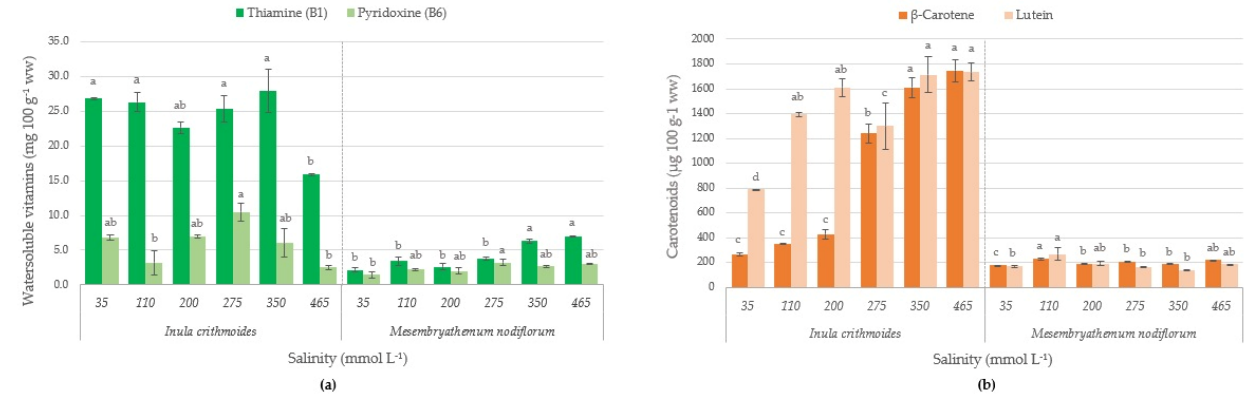
Figure 2. ( a ) Vitamin content and ( b ) carotenoid content of I. crithmoides and M. nodiflorum cultivated at six different salinities. LOD: B1-2.6 µg mL − 1 , B6-2.1 µg mL − 1 , β -Carotene-8.2 µg mL − 1 , Lutein-1.4 µg mL − 1 . In each chart, bars of the same color and labeled with different letters are significantly different ( p < 0.05).